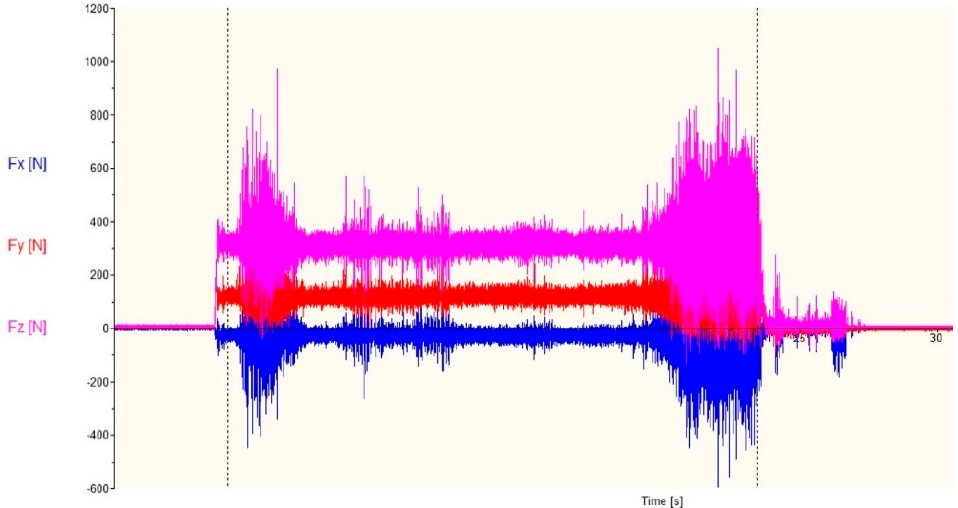
Materials 2020 , 13 , x FOR PEER REVIEW Figure 11. Cutting forces during turning with parameters: ap = 2.0 mm, f = 0.05 mm/rev.